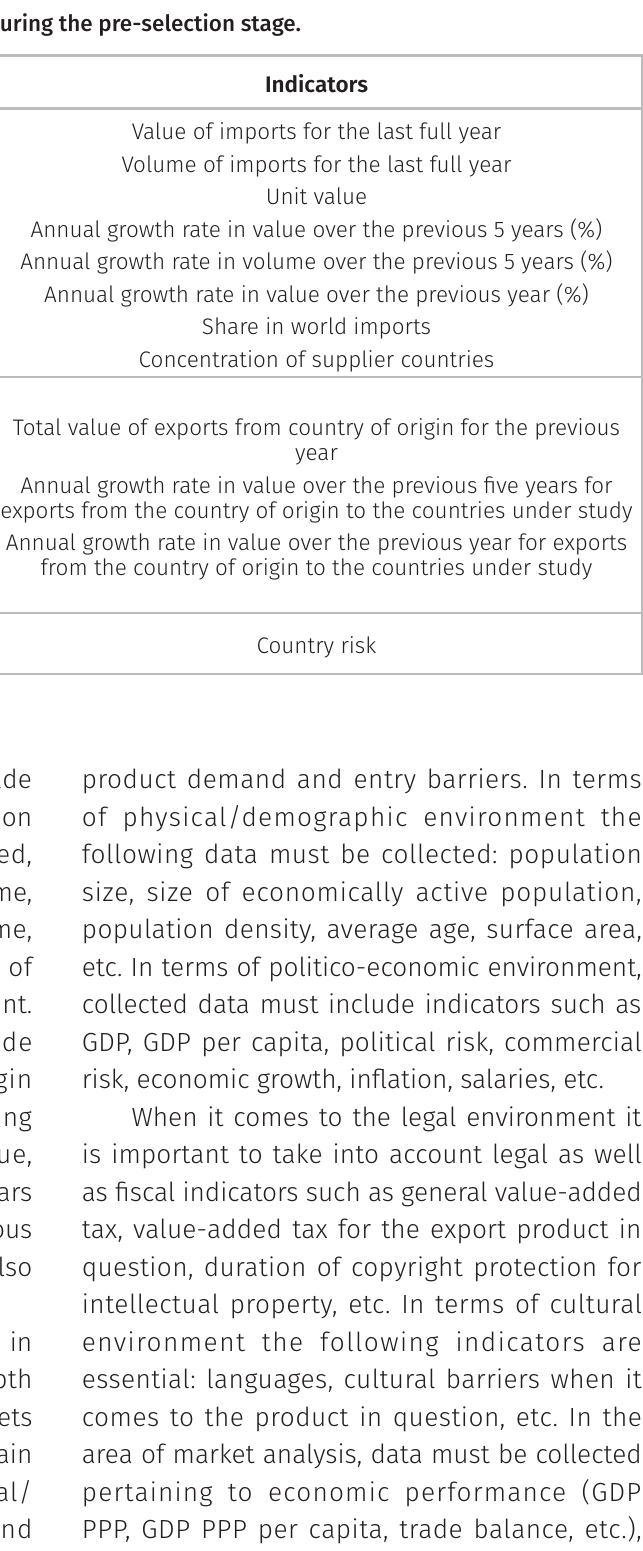
Table IV. Criteria and indicators used in the model during the pre-selection stage. Criteria Indicators Value of imports for the last full year